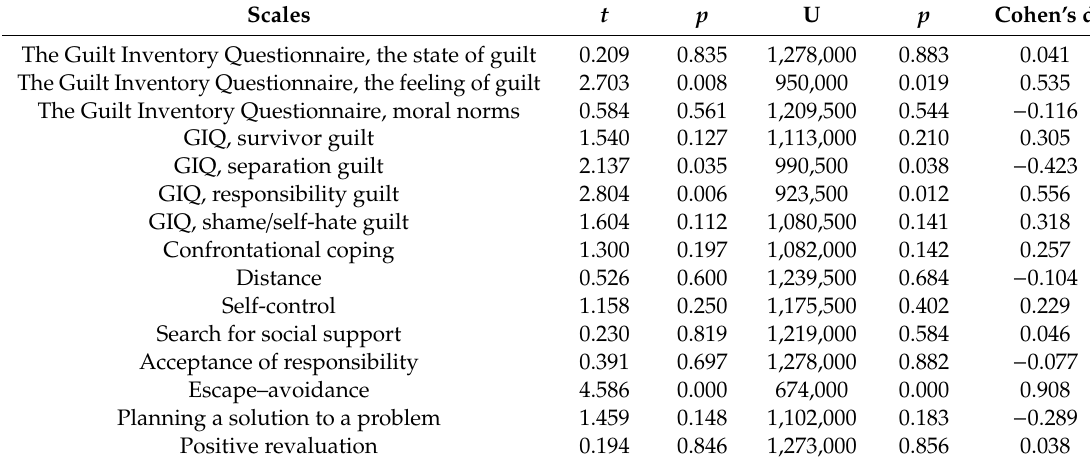
Table 2. Coping strategies and the feeling of guilt experienced by people whose parents were alcohol addicts versus controls (parametric results, nonparametric results, and e ff ect sizes). Scales t p U p Cohen’s